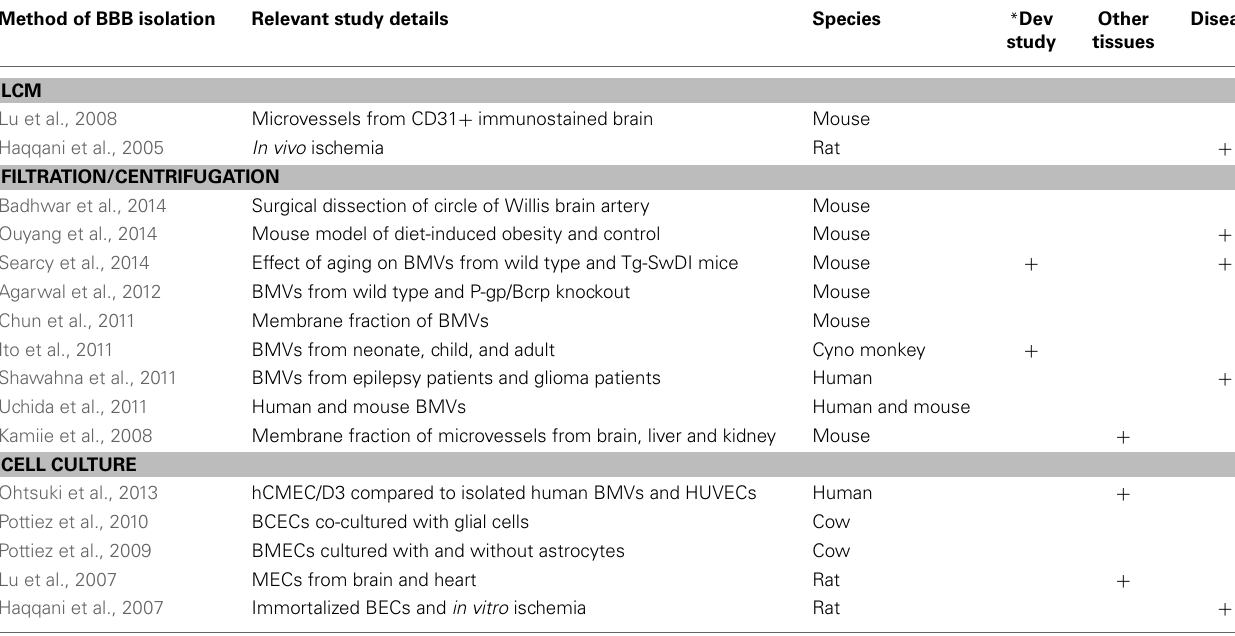
Table 2 | Recent proteomics data sets for the